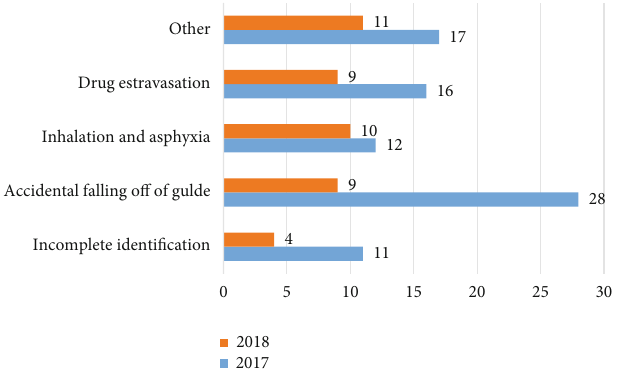
Figure 4: Comparison of the number of adverse events in neonatal pediatric nursing in the fourth quarter of 2017 and